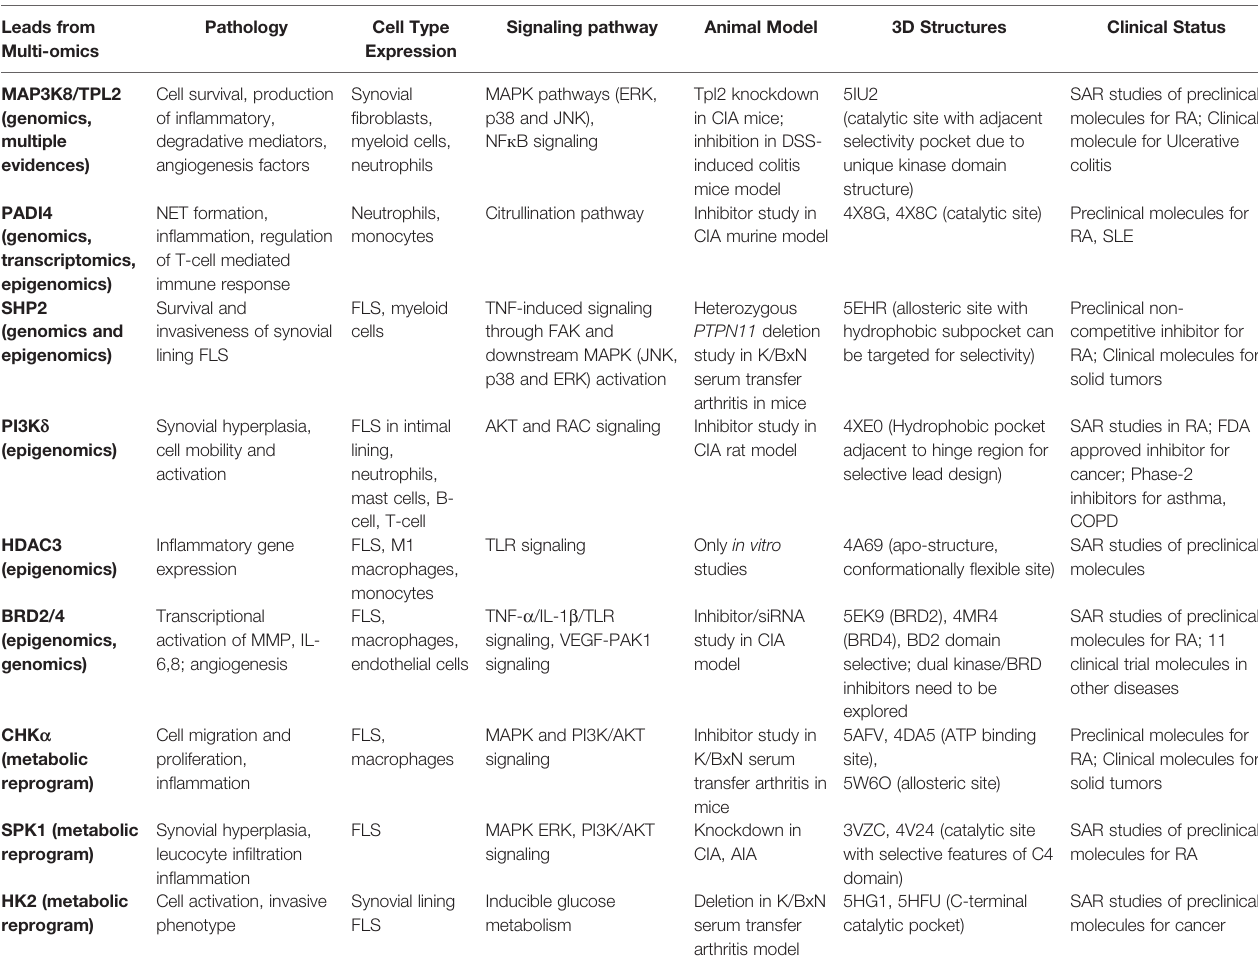
TABLE 2 | Properties of potential druggable targets in